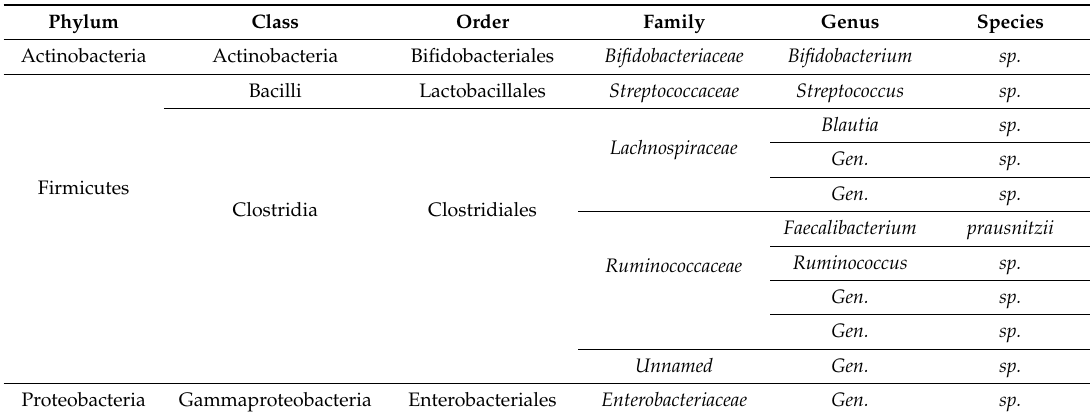
Table 1. The most abundant species obtained by identifying the five species with the highest relative abundance for Control 0 h and 24 h, and per each of the six tested stilbenoid samples at 24 h. Gen. = unnamed genus, sp. = unnamed